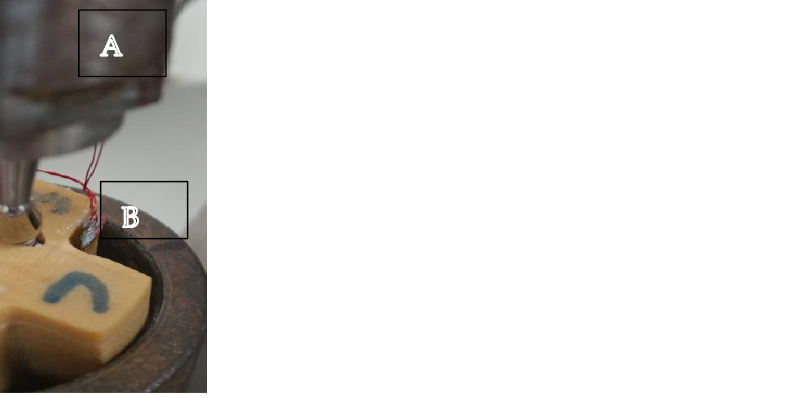
Figure 4. The insertion loading machine ( A ) creates non-axial pressure on the abutment ( B ) connected to the implant.